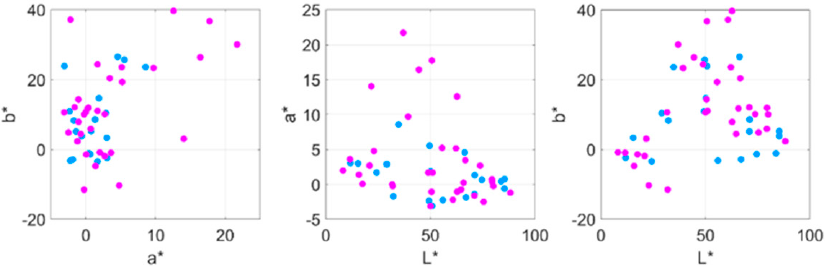
Figure 6. Comparison between the computational colours and relevant colours obtained for the painting Queen Joanna the Mad , by Pradilla, 1877 (which corresponds to image number 19, fourth row, in Figure 1) and one of the observers. Computational colours are marked as blue points, and the obtained experimental relevant colours are marked as magenta circles.